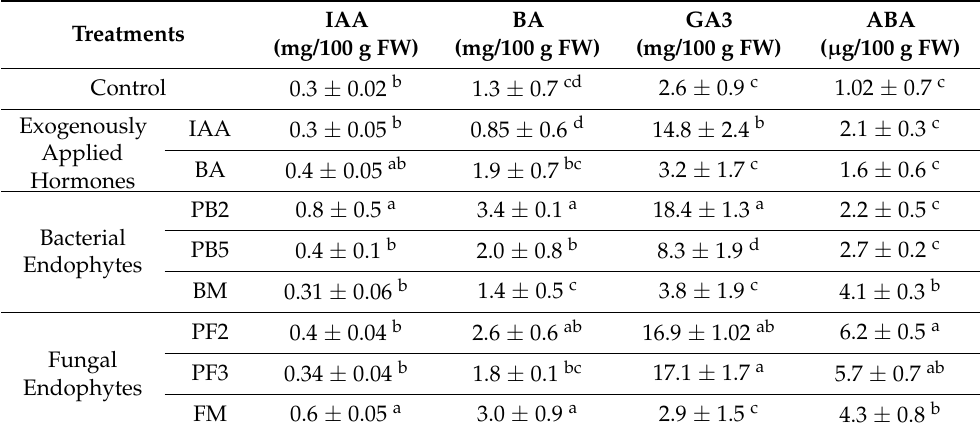
Table 6. Effect of exogenous application of exogenously applied hormones and microbial endophyte metabolites on endogenous levels of indole-3-acetic acid (IAA), benzyl Adenine (BA), gibberellic acid (GA3), and abscisic acid (ABA) of common bean